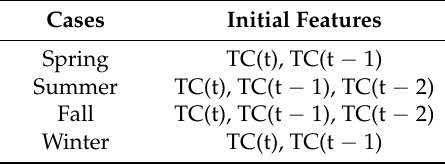
Table 4. The initial features of training samples in four cases.